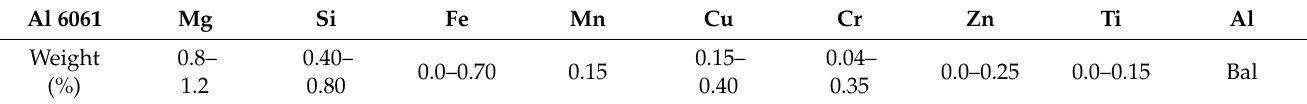
Table 1. Chemical properties of aluminum